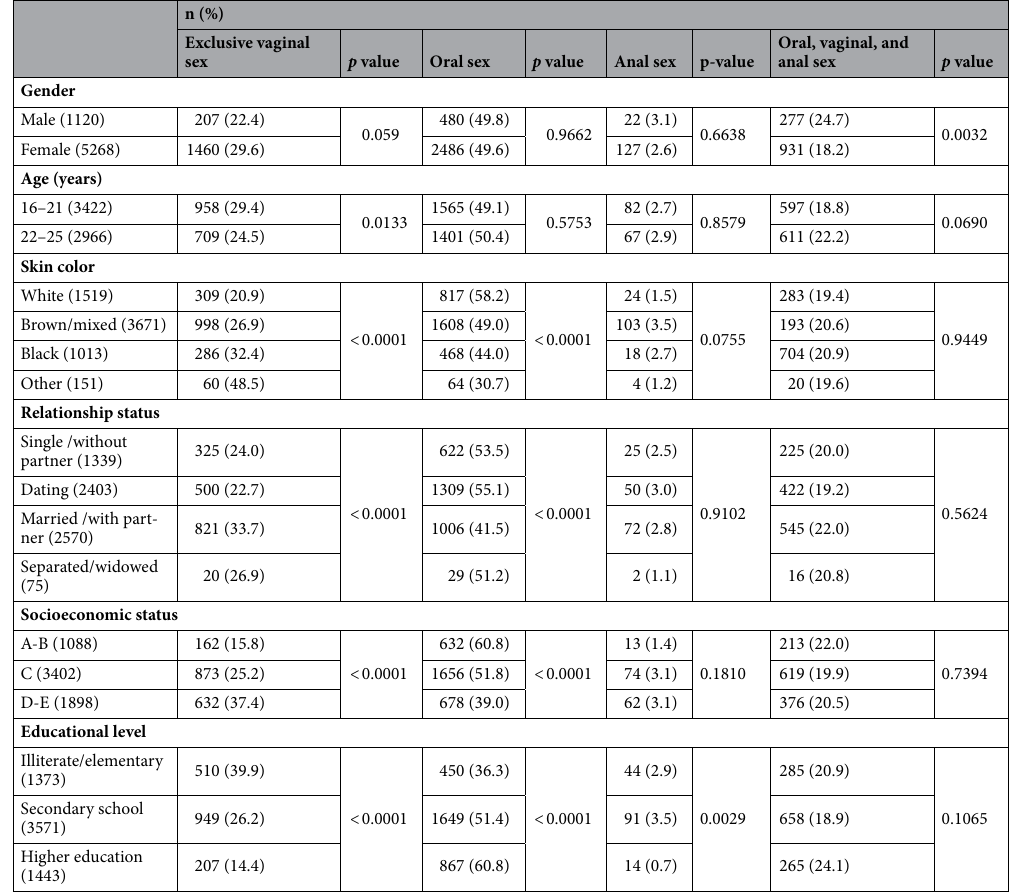
Table 1. Distribution of sociodemographic characteristics of the population studied, according to types of sex practices (n =